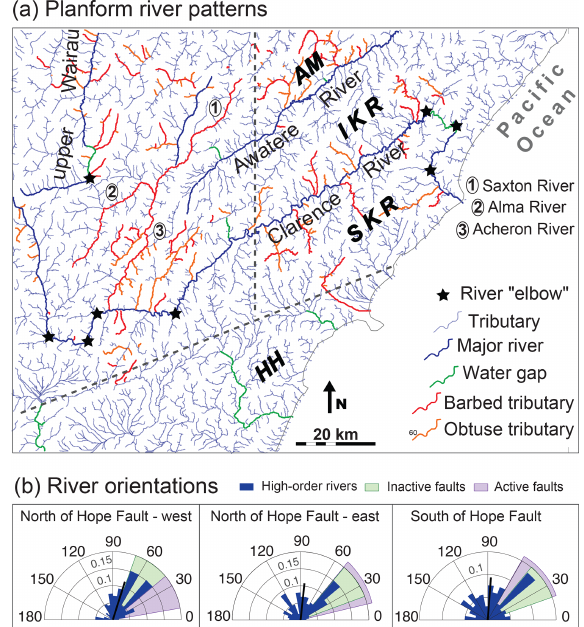
Figure 3. Marlborough Fault System planform river patterns across three geomorphic domains. (a) Map of field site showing rivers and drainage anomalies. Main stem rivers shown in thicker line weight. AM – Awatere mountains, IKR – Inland Kaik¯oura Range, SKR – Seaward Kaik¯oura Range, and HH – Hundalee Hills. Dashed black lines show topographic domain boundaries (same as in Fig. 2) (b) Half-dial plots showing orientations of river segments (blue) of Strahler order 2 and higher. Numbers within dials show the por- tion of segments analyzed. Thin black line shows the circular mean. Each plot also shows the range in orientations of inactive (green) and active (purple) fault segments that represent the three histogram bins with the highest percentage of each feature (see Fig.